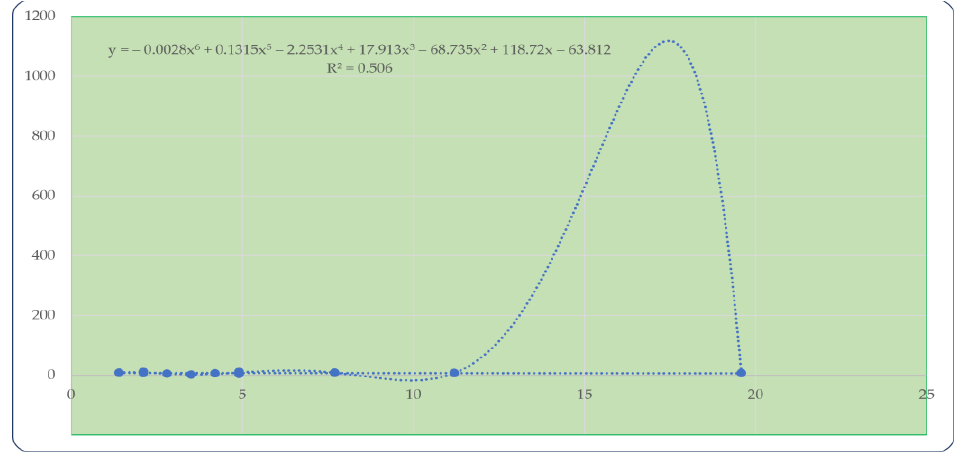
Figure 2. Correlation between dead wolves and damage caused by the canid.